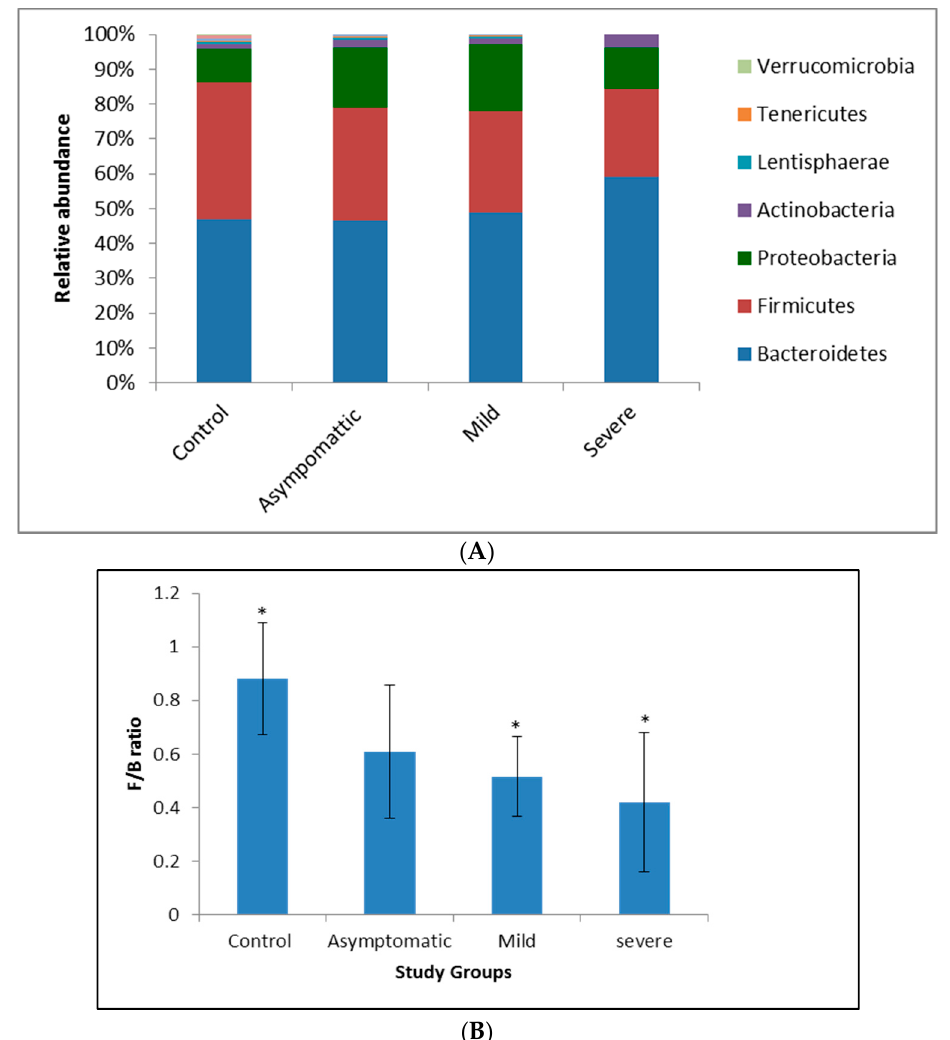
Figure 2. Compositional changes in the gut microbial diversity of COVID-19-infected and -noninfected subjects. Results are expressed as mean ± SD, n = 10. Statistical significance was determined with a Student’s t -test (unpaired, two tailed), * p = 0.05. ( A ): Relative abundance of microbial phyla in the gut of COVID-19-infected and non-infected groups; ( B ): Firmicutes/Bacteroidetes ratio in the gut of COVID-19-infected patients and noninfected groups.